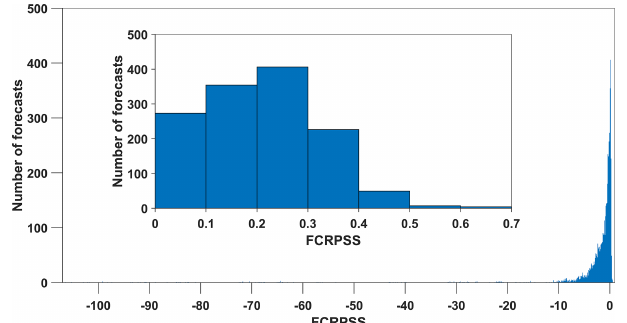
Figure 2. Bar plot showing the distribution of all 5040 FCRPSS values. FCRPSS values are in the range [ − 106 . 38, 0.63]. Inset bar plot shows the distribution of only the 1302 forecasts that are skilful with FCRPSS >